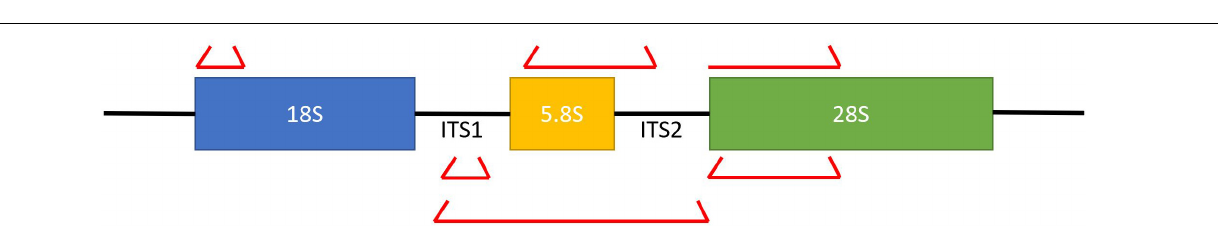
FIGURE 2 | A diagrammatic representation of the various fungal ribosomal genes that can be targeted for sequencing. The ITS sequences provide the best balance of conservation which facilitates targeting,while also providing diversity to differentiate between organisms. The red brackets represent primer sequences that can be utilized to sequence the desired